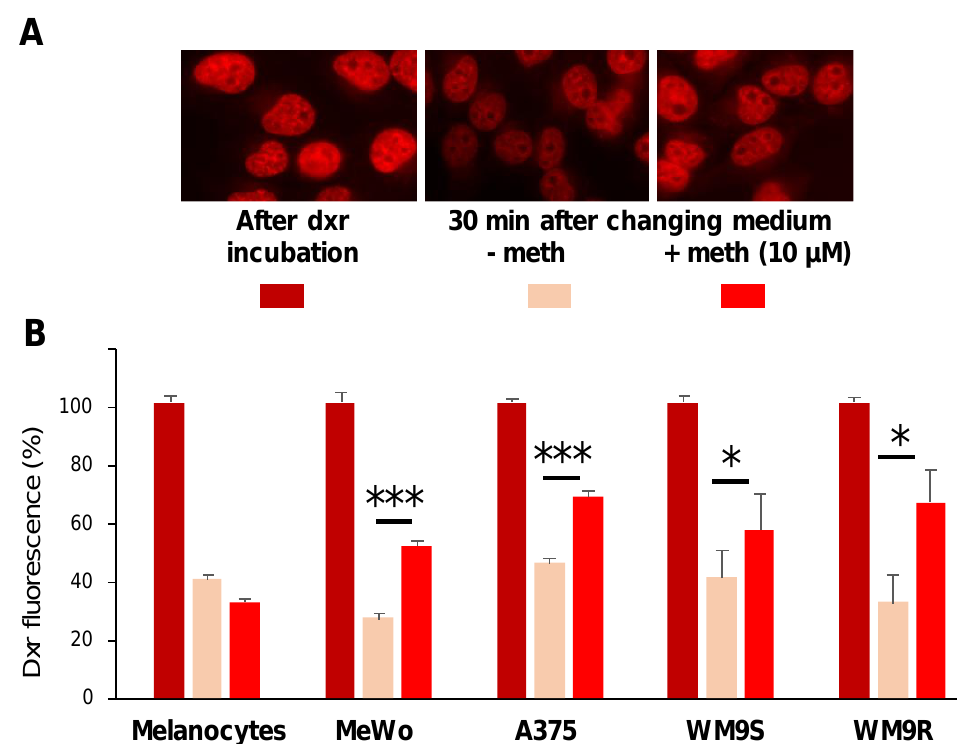
Figure 2. Methiothepin inhibits the doxorubicin efflux activity of Ptch1. Cells from melanocytes, melanoma cell cultures, and melanoma cell lines were seeded on coverslips and incubated with doxorubicin (dxr). After 2 h’ incubation, three coverslips were fixed for dxr loading control. The other coverslips (a triplicate per condition) were incubated with DMSO or methiothepin (meth) for 30 min and fixed. Images of each coverslip were acquired with a fluorescence microscope using a 40 × objective. ( A ) Example of images obtained on MeWo cells. ( B ) Dxr fluorescence was quantified using ImageJ software for about 100 cells per condition per experiment. Histograms represent the mean ± SEM of at least three independent experiments and were analyzed using ANOVA multiple comparison test and Bonferroni correction. Significance was attained at p < 0.05 (*). ***: p < 0.0005.